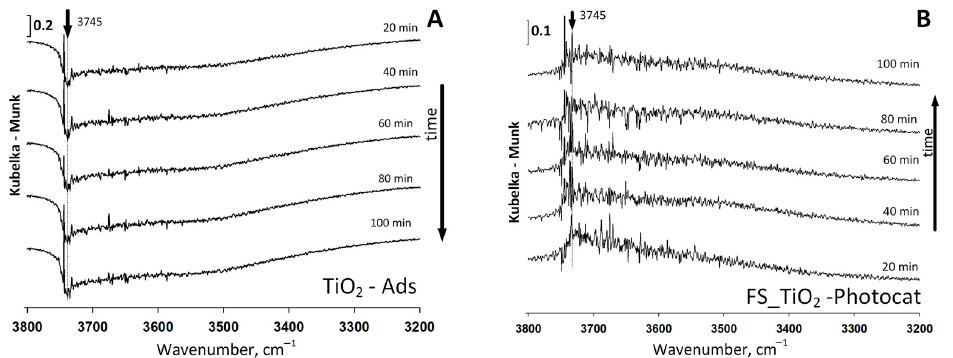
Figure 9. Evolution of subtracted DRIFTS spectra of the OH stretching vibration zone during the adsorption step ( A ) and photocatalytic degradation step of ethylene ( B ) onto TiO 2 mixed with raw fumed silica (FS_TiO 2 ).